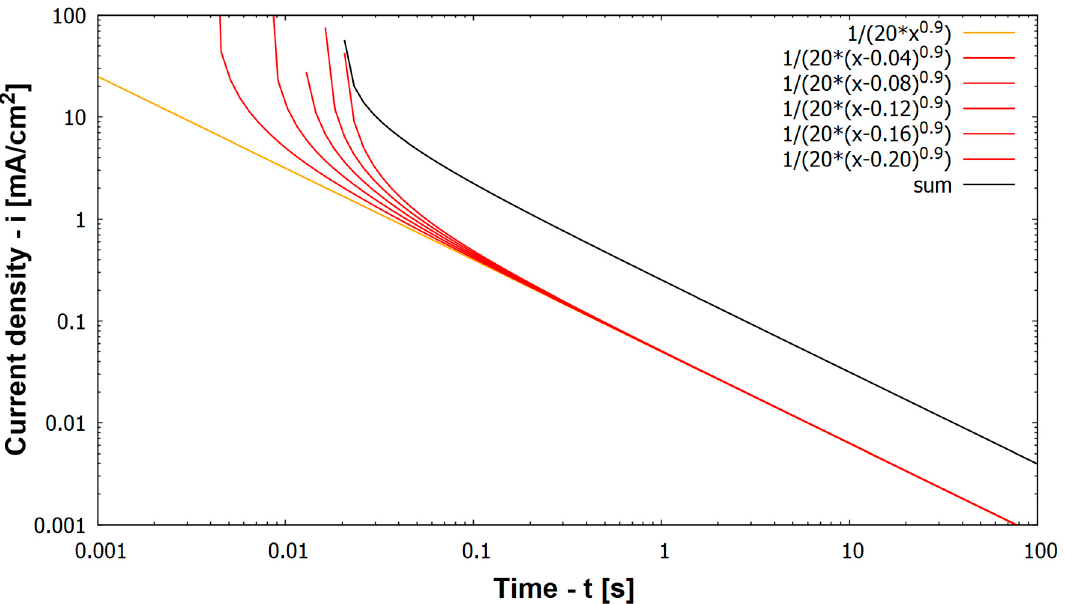
Figure 7. Simulation of repassivation behavior for a full scratch (black line) and for discrete and time shifted parts of the scratch by using Equation (2) (sum of red lines is black line), orange line indicates instantaneous start of repassivation.